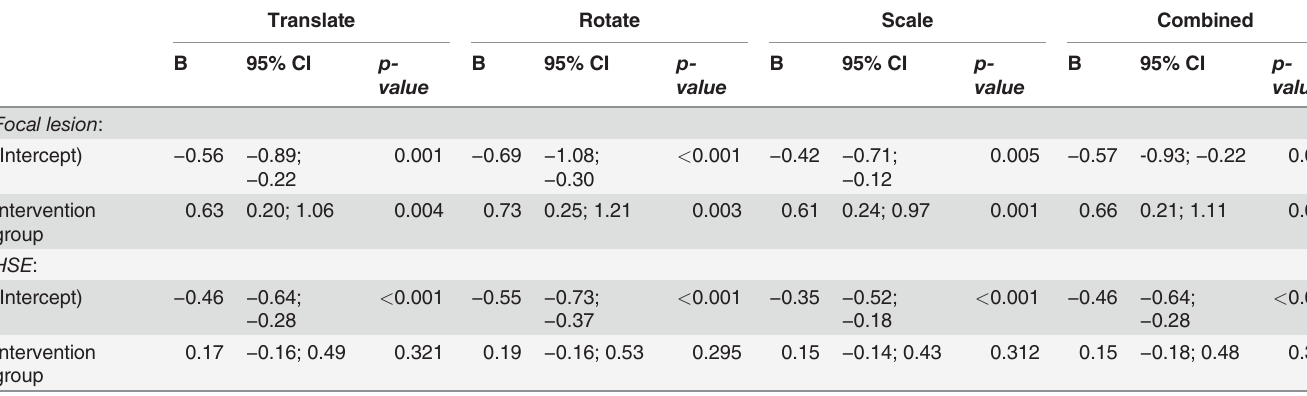
Table 7. Registration errors: effect of an intervention. Translate Rotate Scale Combined